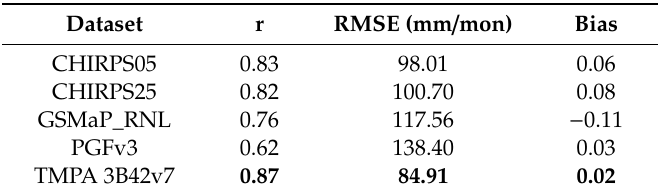
Table 4. Summary of statistical measures for five monthly gridded precipitation datasets. The best values for each statistical indicator are shown in bold.